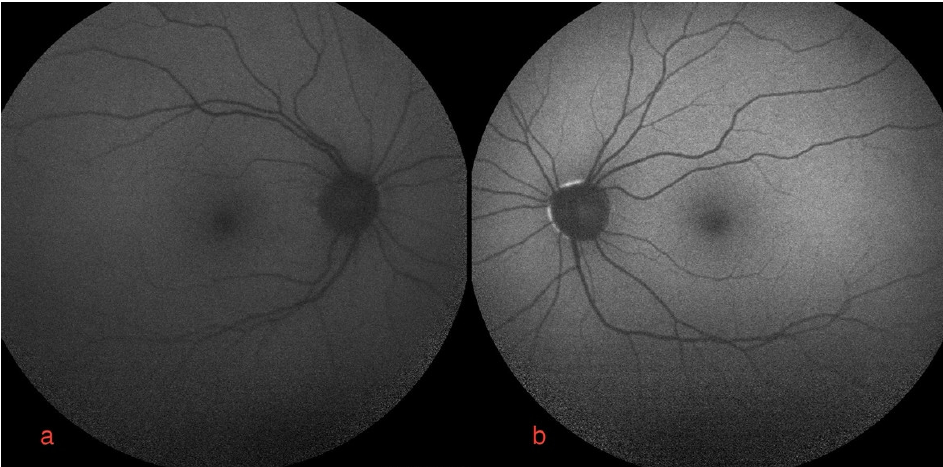
Figure 3. Autofluorescence imaging of right ( a ) and left eye ( b ). Bilateral FGFRARshows normal autofluorescence imagine.